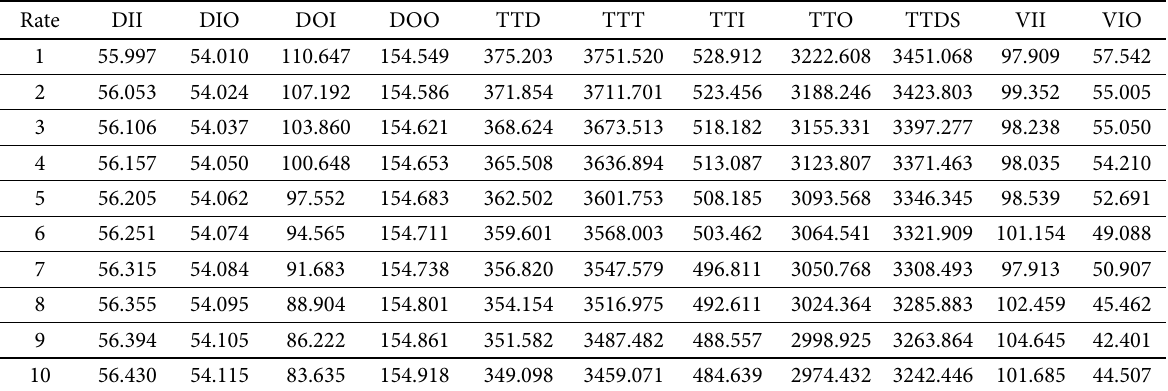
Table 2. Sensitivity analysis of cordon pricing